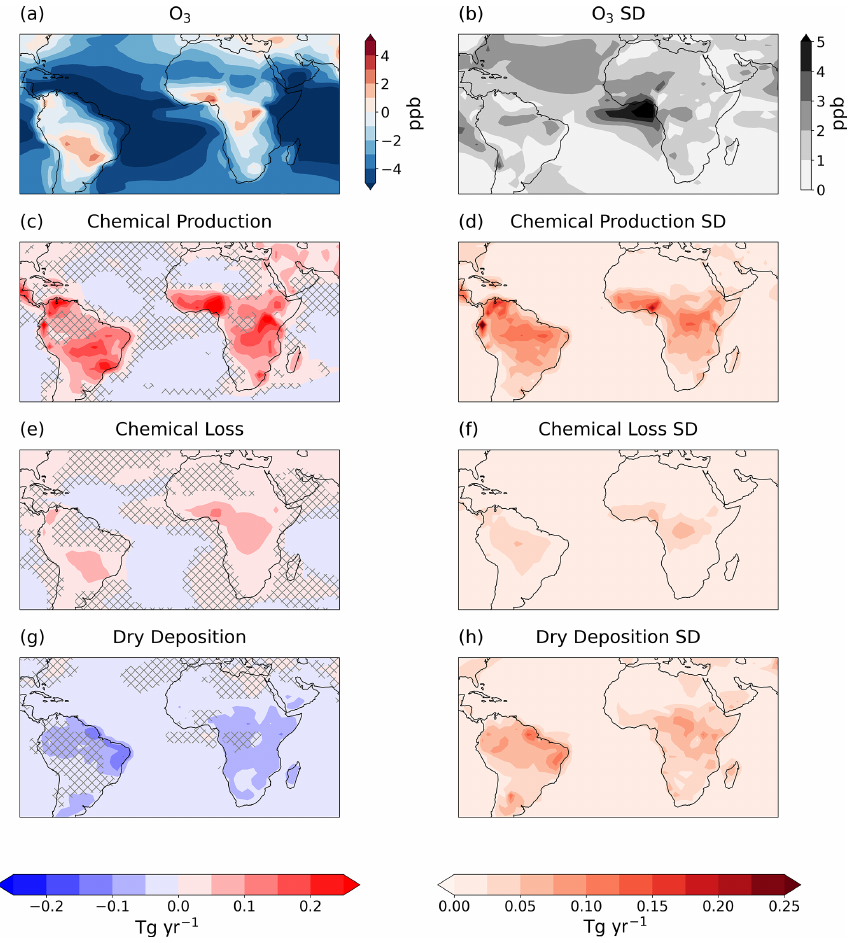
Figure 5. The multimodel mean change in (a) surface O 3 concentration, (c) chemical production of O 3 , (e) chemical destruction of O 3 and (g) dry deposition of O 3 due to climate change. Panels (c) , (e) and (g) show the change in O 3 in Tgyr − 1 , and chemical terms have been summed over a 1km height. The inter-model standard deviations are shown in panels (b) , (d) , (f) and (h)